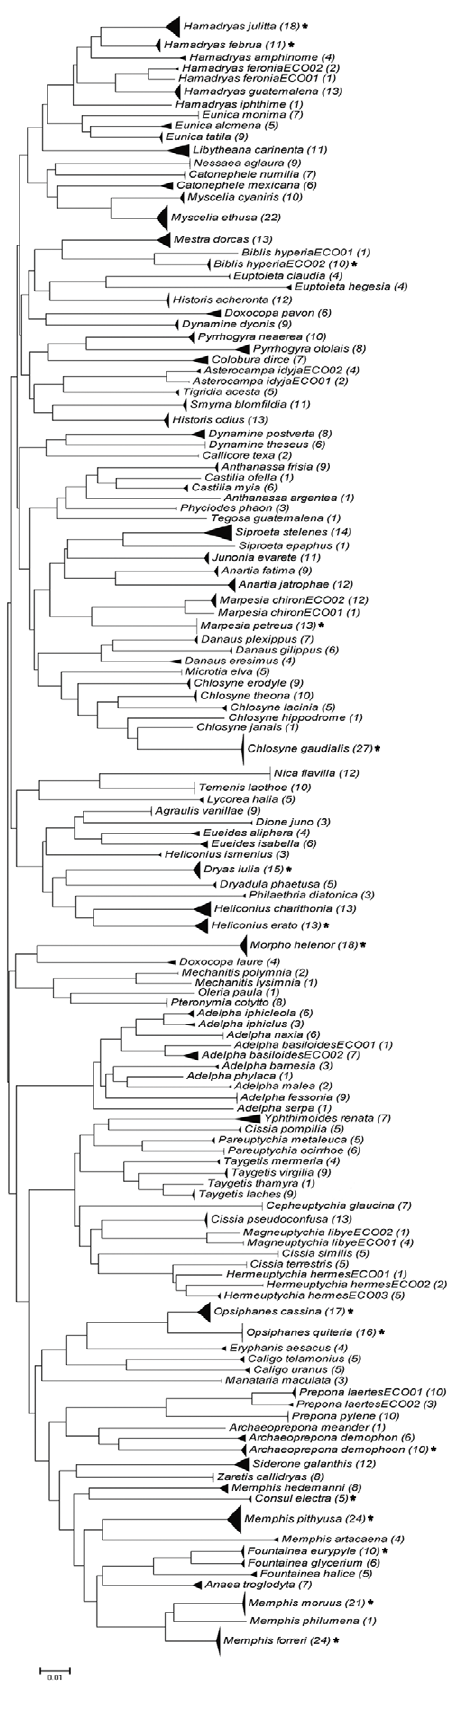
Figure 2. Neighbour Joining tree for 121 species of Nympha- lidae from the Yucatan Peninsula. Tree is based on genetic distances (K2P) for the barcode region of the COI gene; the height of each triangle indicates mean intraspecific sequence divergence, while the base of the triangle provides a rough indication of the number of specimens analyzed. Brackets enclose the number of barcodes generated for each species and those with an asterisk include both caterpillars and